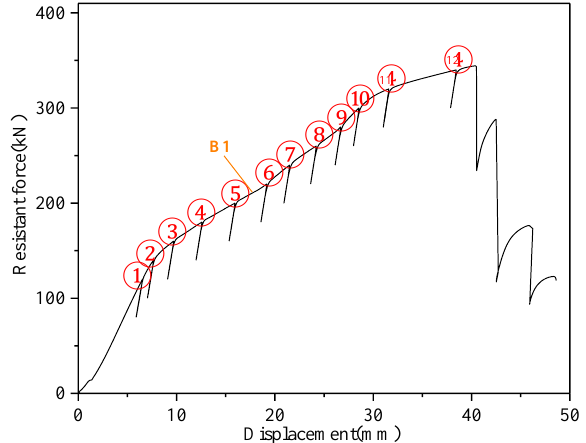
Figure 14. Tensile resistance–displacement curve of increasing-lower-limit-and-equiamplitude cyclic loading.